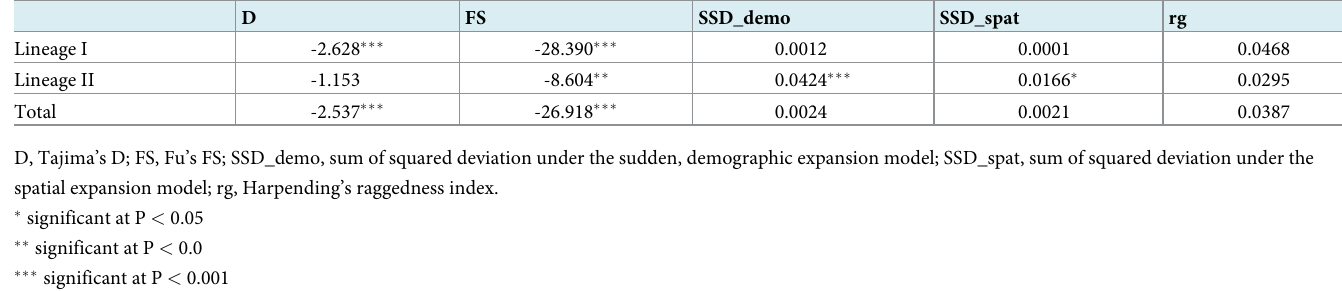
of region ‘West’ (H ranged from 0.579 to 0.596 and A from 3.625 to 5.063). Multilocus F E R values were not significant in any sample. The H and A decreased with increasing latitude E R (r = -0.55, p = 0.004 and r = -0.59, p = 0.002, respectively) (Fig 3C), but no significant pattern with longitude was detected (r = 0.27, p = 0.198 and r = 0.12, p = 0.561, respectively). The